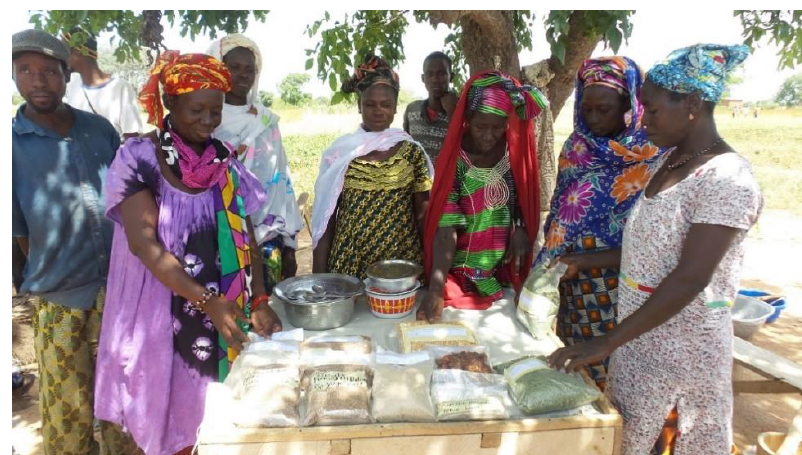
Figure 4. Women with their processed products in Bolimasso, Mali promoting the use and commercialization of fonio and Bambara groundnuts. Credit: Bioversity International/G. Meldrum.